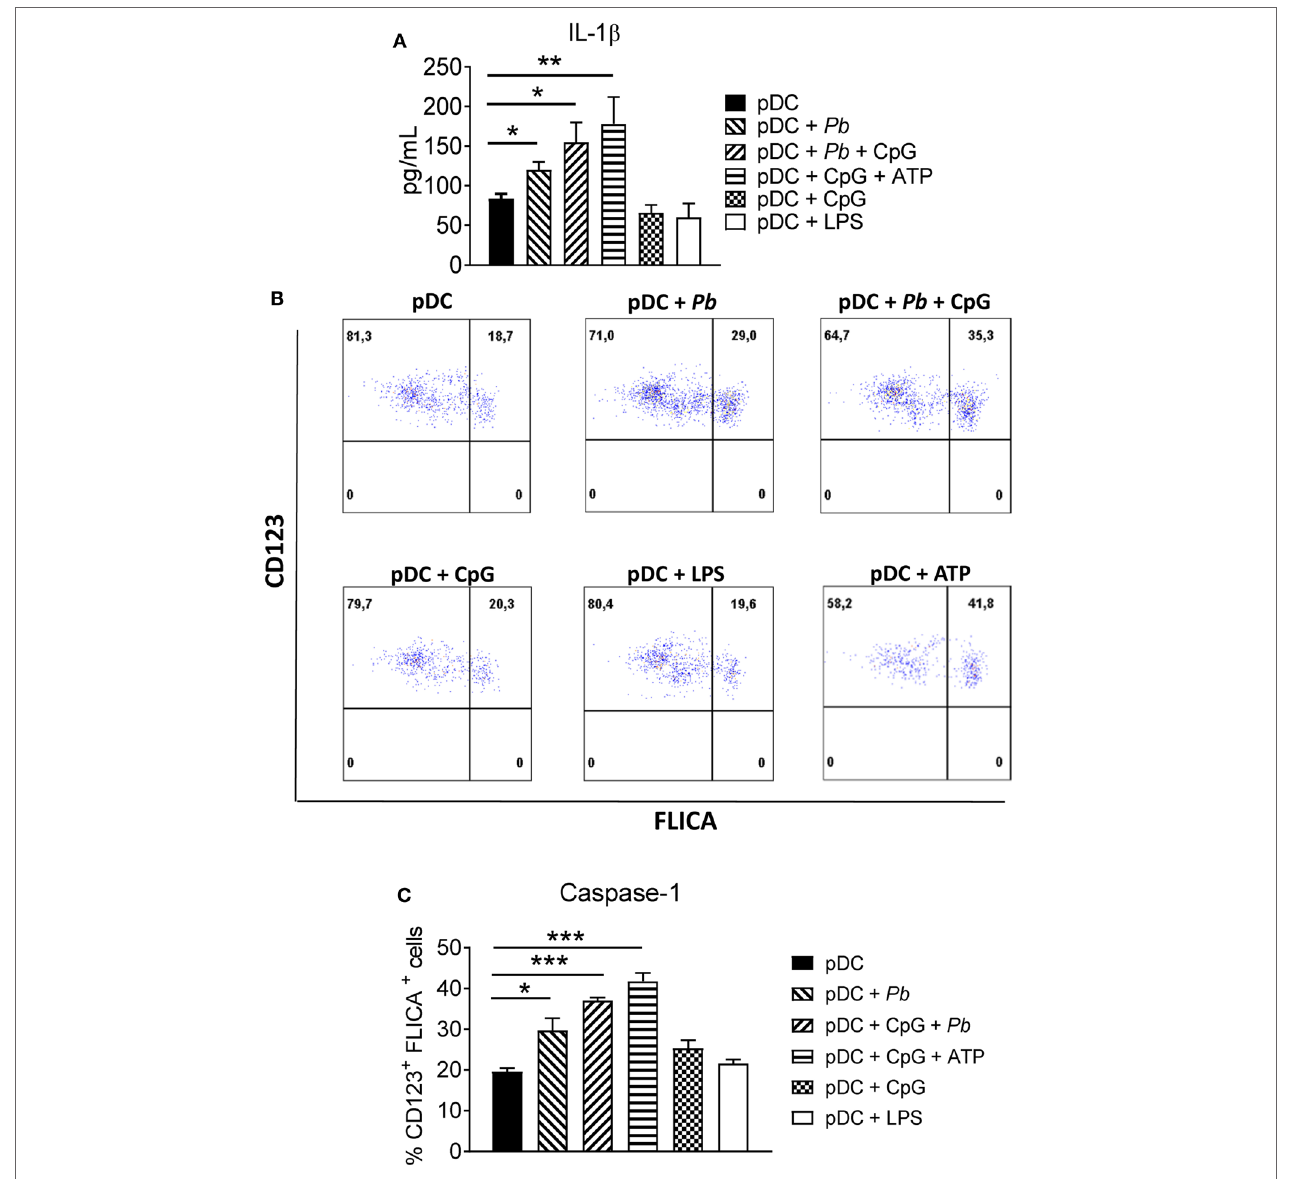
FigUre 3 | Plasmacytoid dendritic cell (pDC) exposed to Paracoccidioides brasiliensis yeast cells secretes mature IL-1 β and express activated caspase-1. (a) Peripheral blood mononuclear cells (PBMCs) were separated into pDC positive (pDCs + ) cells using magnetic beads conjugated to anti-CD304 antibodies. The cells (1 × 10 5 /well) were then left without stimulation or challenged overnight with P. brasiliensis yeast cells (2 × 10 3 ), CpG (100 ng/mL), or LPS (10 ng/mL). The supernatant was removed and the levels of IL-1 β were analyzed by ELISA. Data are represented as the mean ± SE of the average cytokine concentrations from three donors, tested in duplicate. * p < 0.05 by comparing the data indicated by the bar. (B,c) Caspase-1 activity was evaluated by flow cytometry. PBMCs were separated into pDC positive (pDCs + ) populations using magnetic beads conjugated to anti-CD304 antibodies. The cells (2 × 10 5 /well) were left without stimulation or challenged overnight with P. brasiliensis yeast cells (4 × 10 3 ), CpG (100 ng/mL), or LPS (10 ng/mL). Cells were stained with FLICA probe for 1 h and the percentage of CD123 + FLICA + cells were determined by flow cytometry. (B) Dot plots are representative results of an experiment from two independent experiments. (c) Data are represented as the mean ± SE of CD123 + FLICA + cells from two donors, tested in duplicate. * p < 0.05, ** p < 0.01, *** p < 0.001 by comparing the data indicated by the